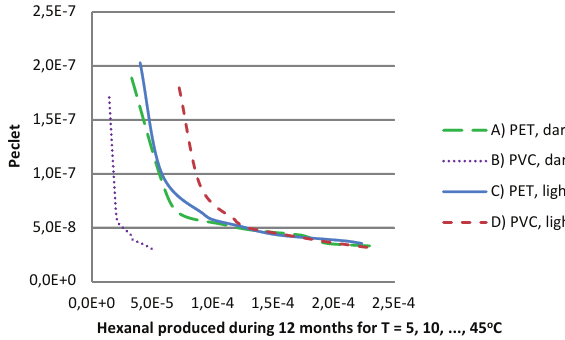
Figure 4: Peclet number as a function of overall hexanal